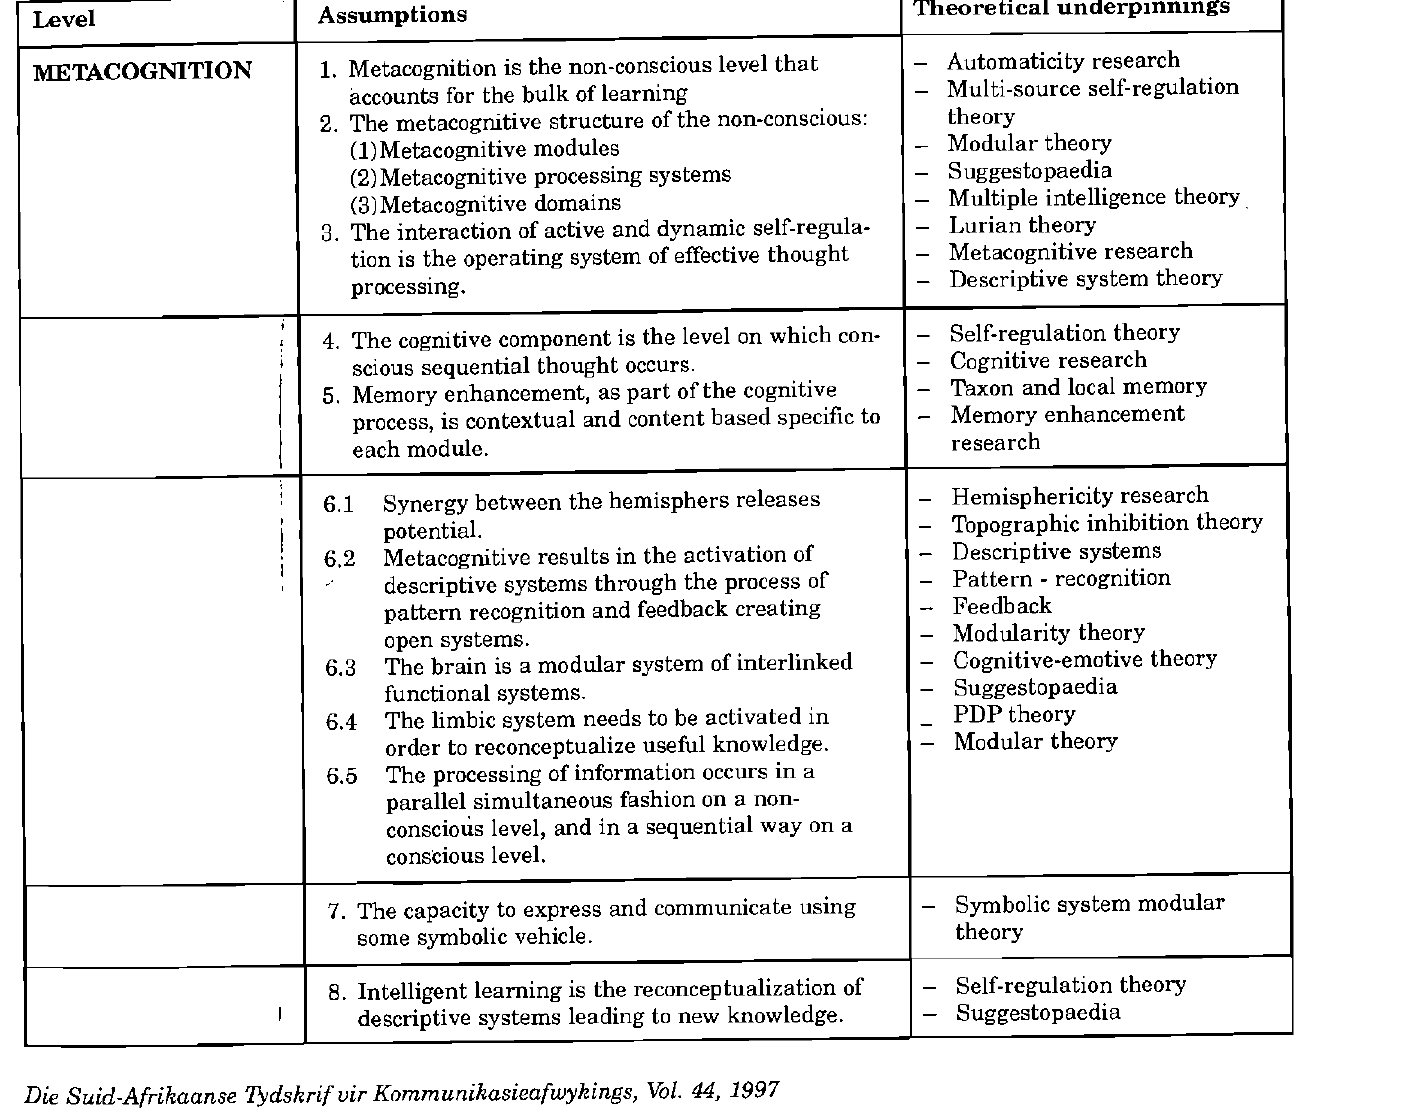
Theoretical underpinnings